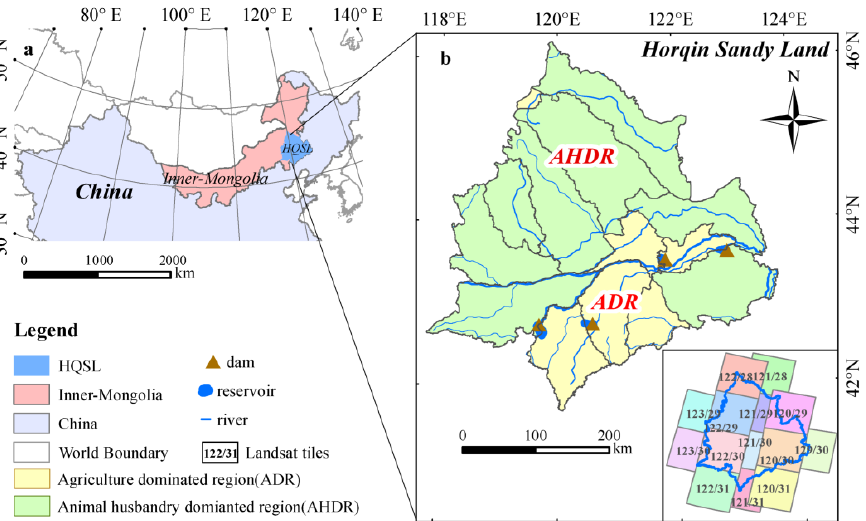
Figure 1. Location of HQSL in Inner-Mongolia region of China: ( a ) is the location of Inner-Mongolia (pink shade) in China, and HQSL (blue shade) in Inner-Mongolia; ( b ) shows the main dams, rivers, and reservoirs in HQSL, and the inserted map shows the tiles of Landsat images covering HQSL.